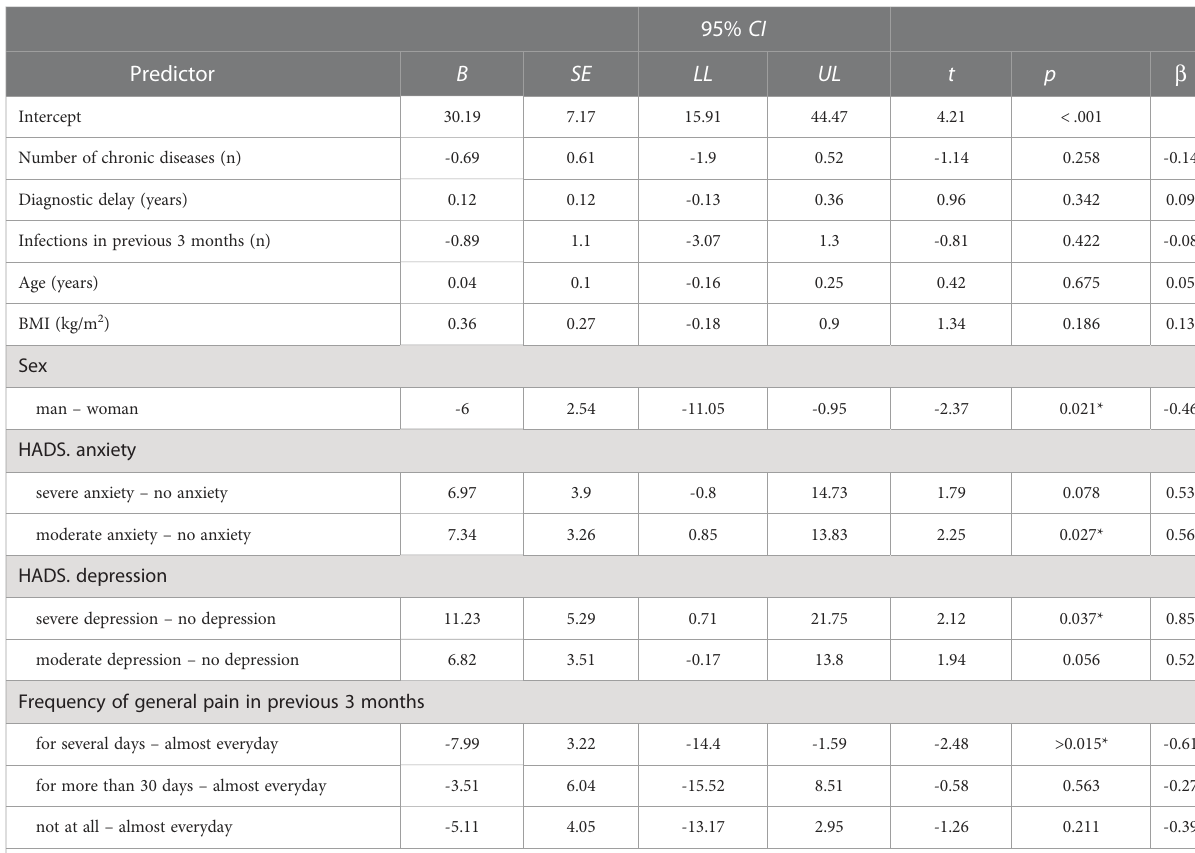
TABLE 10 Multiple linear regression model for